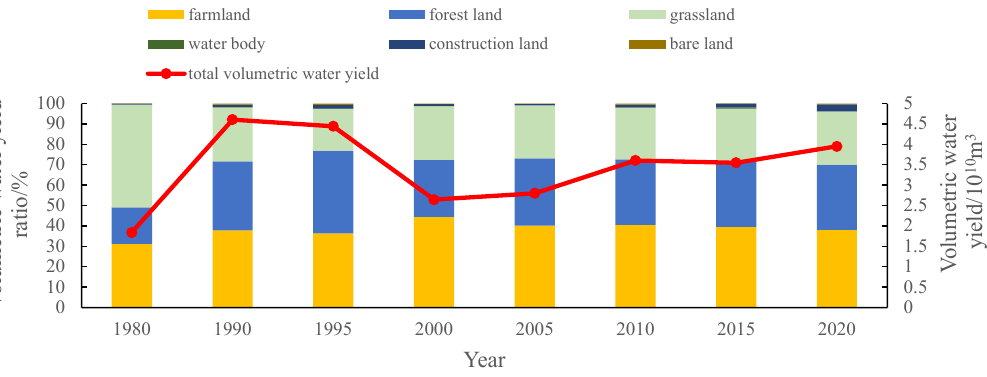
Figure 9. Volumetric water yield ratio of different land use/land cover in the eight years during 1980–2020.